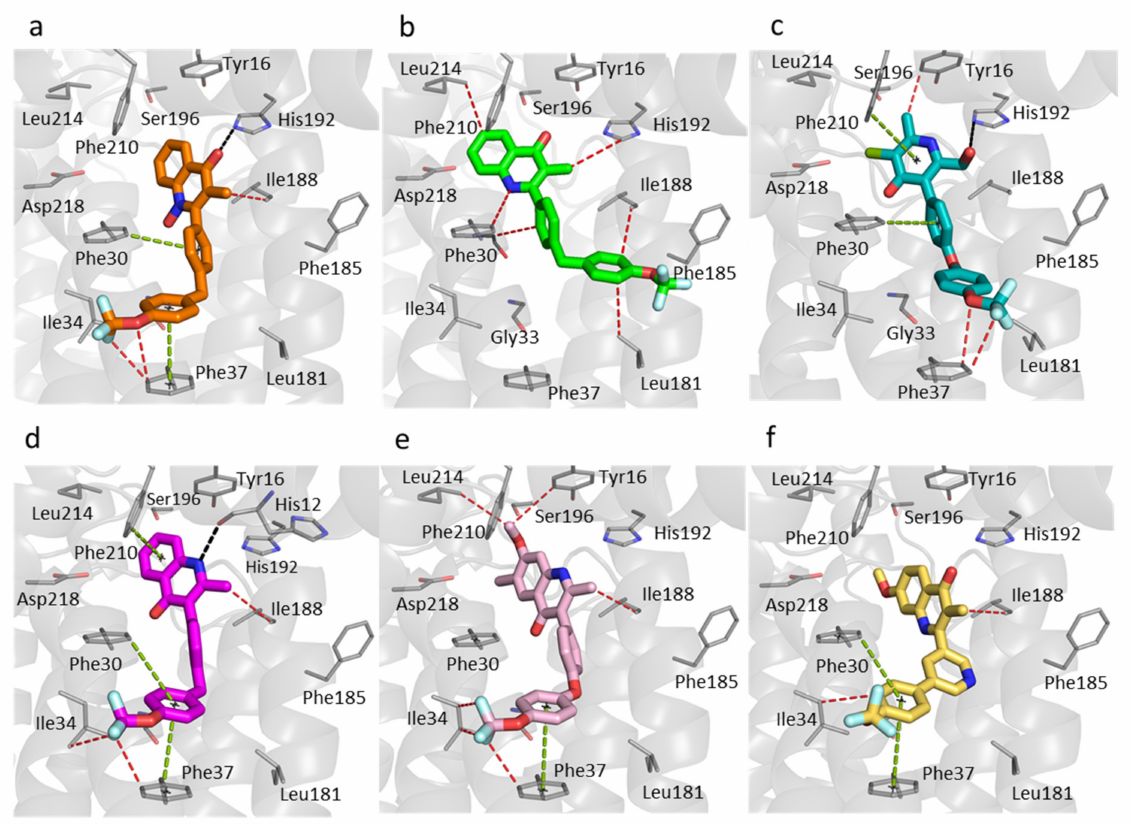
Figure 5. Molecular docking within the Q i site of P. falciparum cytochrome bc 1 . The predicted binding mode of each compound. ( a ) RKA066 (orange sticks). ( b ) CK-2-67 (green sticks). ( c ) GSK932121 (teal sticks). ( d ) WDH-1U-4 (magenta sticks). ( e ) ELQ300 (pink sticks). ( f ) SCR0911 (yellow sticks). Black, cyan, green, and red dashes represent hydrogen bonds, electrostatic, π - π stacking, and hydrophobic interactions between ligands and protein residues, respectively. The grey cartoon represents bovine cytochrome b